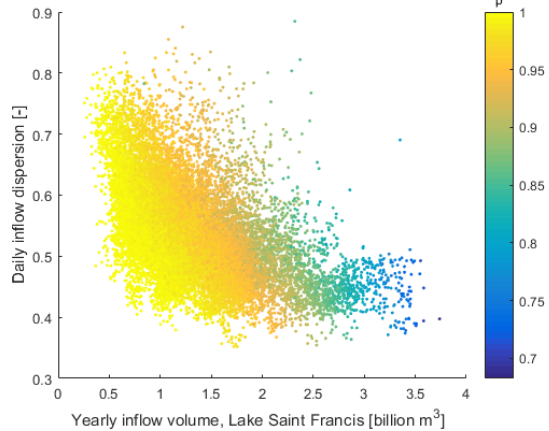
Figure 6. Response surface (Rule 1). Performance R is the flood control